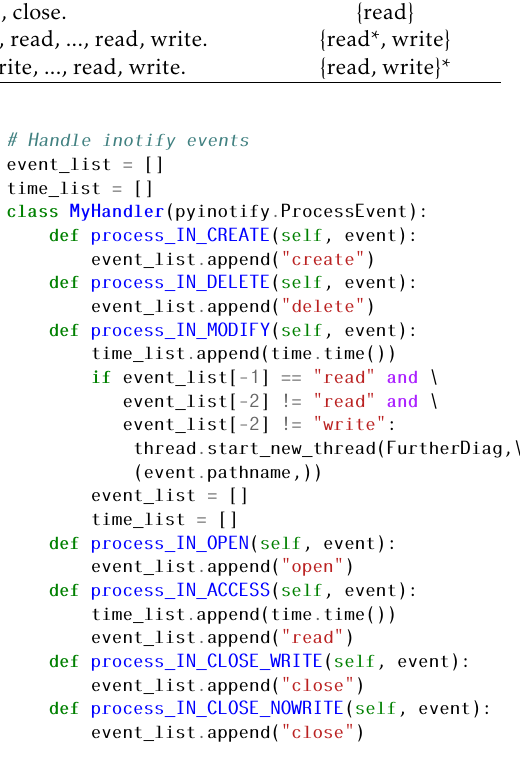
Figure 3. Event handler for local